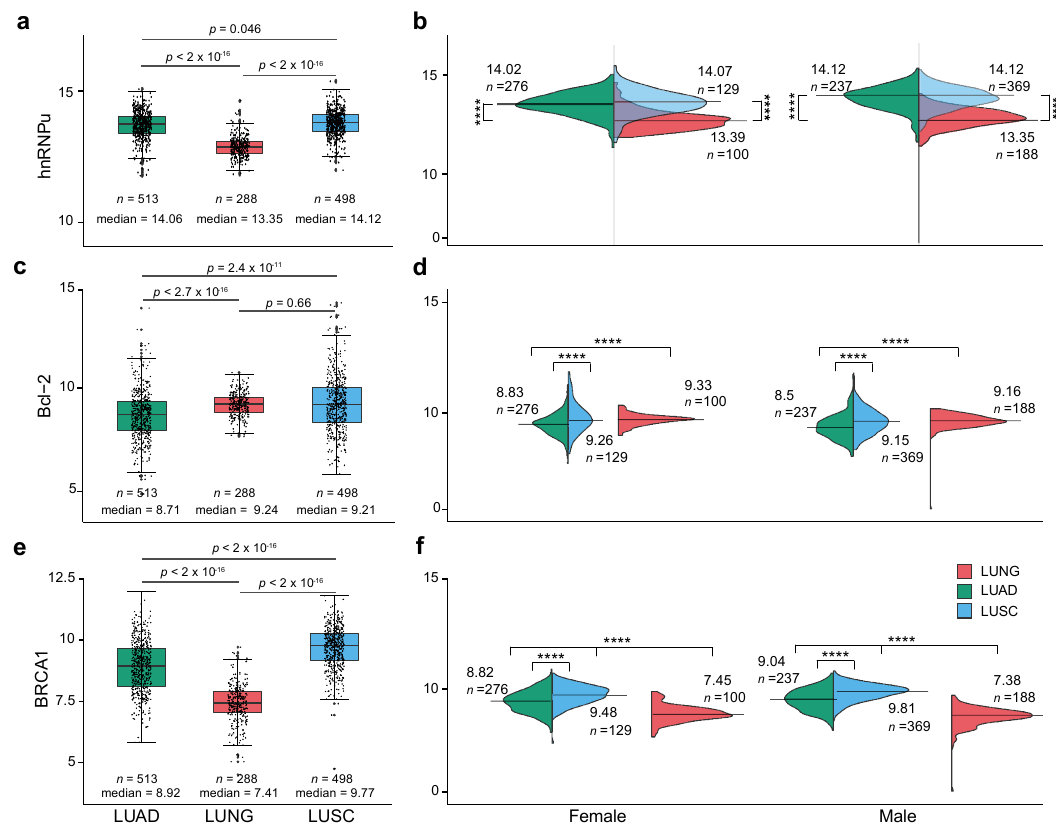
Figure 3. Gene expression patterns for ( a , b ) hnRNPu , ( c , d ) Bcl-2 and ( e , f ) BRCA1 in units of log 2 (norm_count + 1) for normal lung, lung adenocarcinoma (LUAD) and lung squamous cell carcinoma (LUSC). Median expression and sample size were labelled. Median expression and total sample size (count, n) are shown. p -values were calculated the Wilcoxon test in R, statistically, significant represented as ****: p ≤ 0.0001, non-significant results are not labelled in the graph.